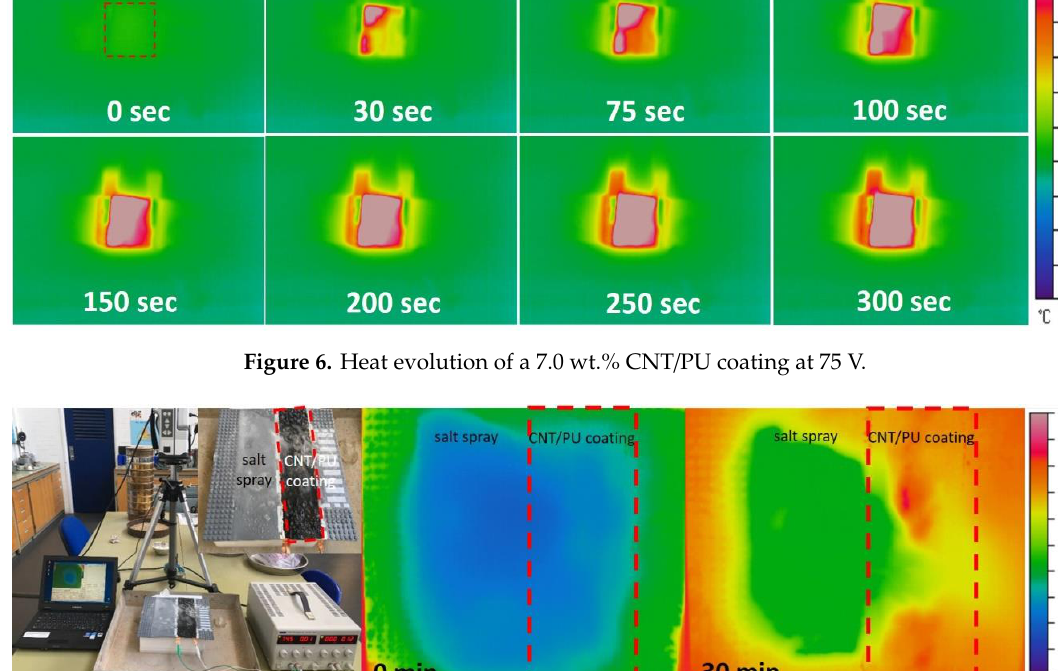
Figure 8. Schematic illustration of CNT/PU coating on the asphalt roads (left) and Estimated normalized resistance and power of the CNT/PU coating on asphalt road (right). 4. Conclusions This study shows the feasibility of multi-functional CNT/PU coatings for future road surface design. Highly electrically conductive road coating materials were successfully fabricated by the dispersion of CNTs in the polyurethane matrix. The addition of CNTs showed enhanced hydrophobicity and electrical conductivity. Proposed CNT/PU coatings also provided freezing temperature sensing due to a negative temperature coefficient. In addition to the freezing temperature sensing, the CNT/PU coatings generated an amount of heat over the surface due to the Joule heating effect. In this study, the CNT/PU coating with a higher CNT concentration was more efficient to monitor the temperature and to generate heat. Therefore, we believe that highly conductive mixes consisting of CNTs and PU may have potential in smart transport road coating systems by being able to detect freezing temperatures and de-icing for winter maintenance. Author Contributions: Conceptualization, S.-H.J. and H.Y; methodology, S.-H.J.; formal analysis, S.-H.J; investigation, S.-H.J.; writing—original draft preparation, S.-H.J.; writing—review and editing, S.-H.J. and H.Y.; visualization, S.-G.Y.; supervision, S.-H.J.; project administration, S.-H.J; funding acquisition, S.-H.J. All authors have read and agreed to the published version of the manuscript. Funding: This research was funded by the Korea Agency for Infrastructure Technology Advancement (KAIA), the Ministry of Land, Infrastructure and Transport from the South Korea (Grant KAIA20CTAP-C157167-01). Acknowledgments: The acknowledge any support of Korea Agency for Infrastructure Technology Advancement (KAIA), the Ministry of Land, Infrastructure and Transport from the South Korea (Grant KAIA20CTAP-C157167-01). Conflicts of Interest: The authors declare no conflict of interest.